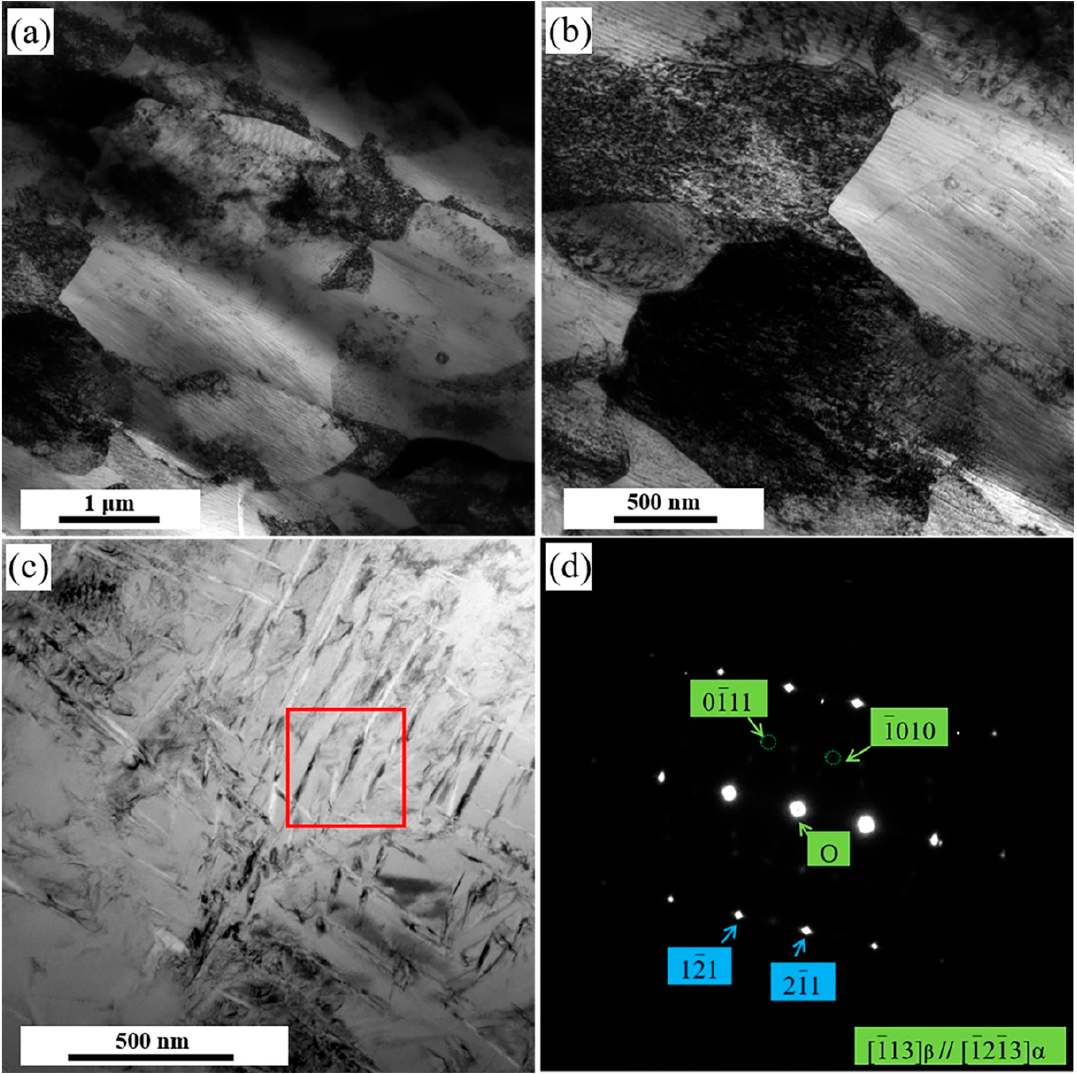
Figure 6. TEM micrographs of Ti555211 alloy deformed at 750 °C and a strain rate of 5 s − 1 : ( a ) Bright field image with high magnification; ( b ) Bright field image with low magnification; ( c ) Bright field image including α and β phases; ( d ) Selected area diffraction pattern in ( c ).